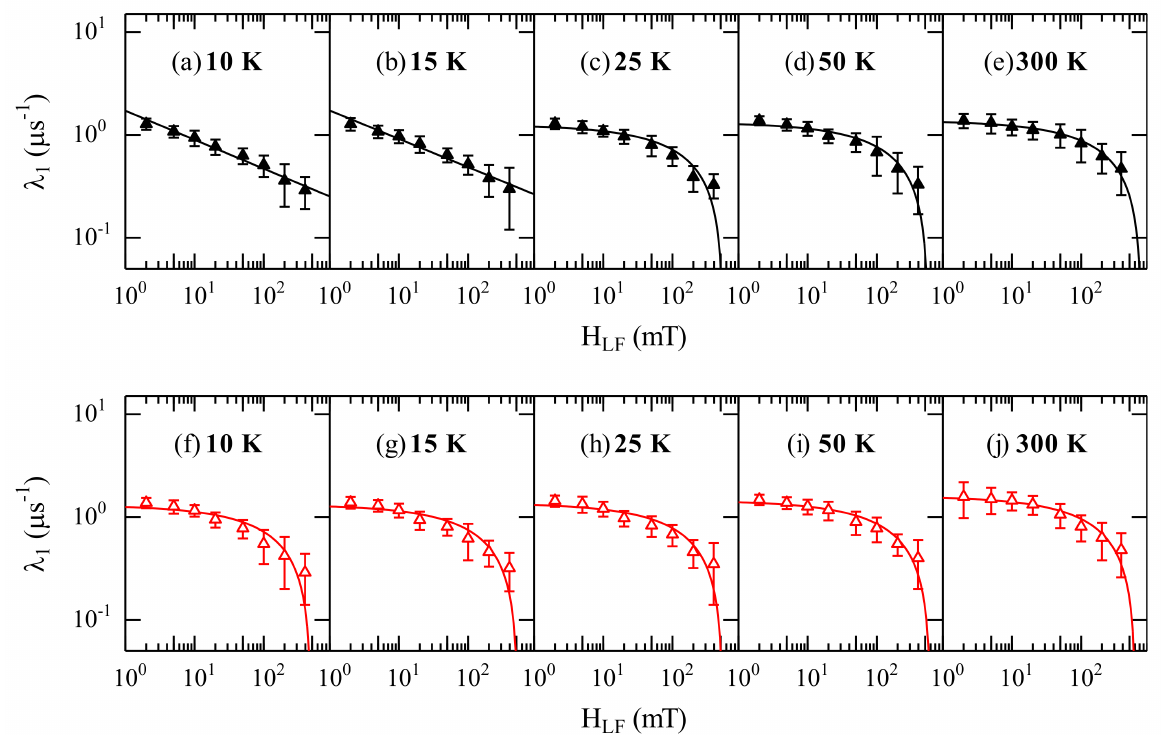
Figure 4. The longitudinal field dependence H LF of the relaxation rate λ 1 of the regio-regular P3HT–ZnO nanoparticles without light irradiation at temperatures of ( a ) 10 K, ( b ) 15 K, ( c ) 25 K, ( d ) 50 K, and ( e ) 300 K and with light irradiation at temperatures of ( f ) 10 K, ( g ) 15 K, ( h ) 25 K, ( i ) 50 K, and ( j ) 300